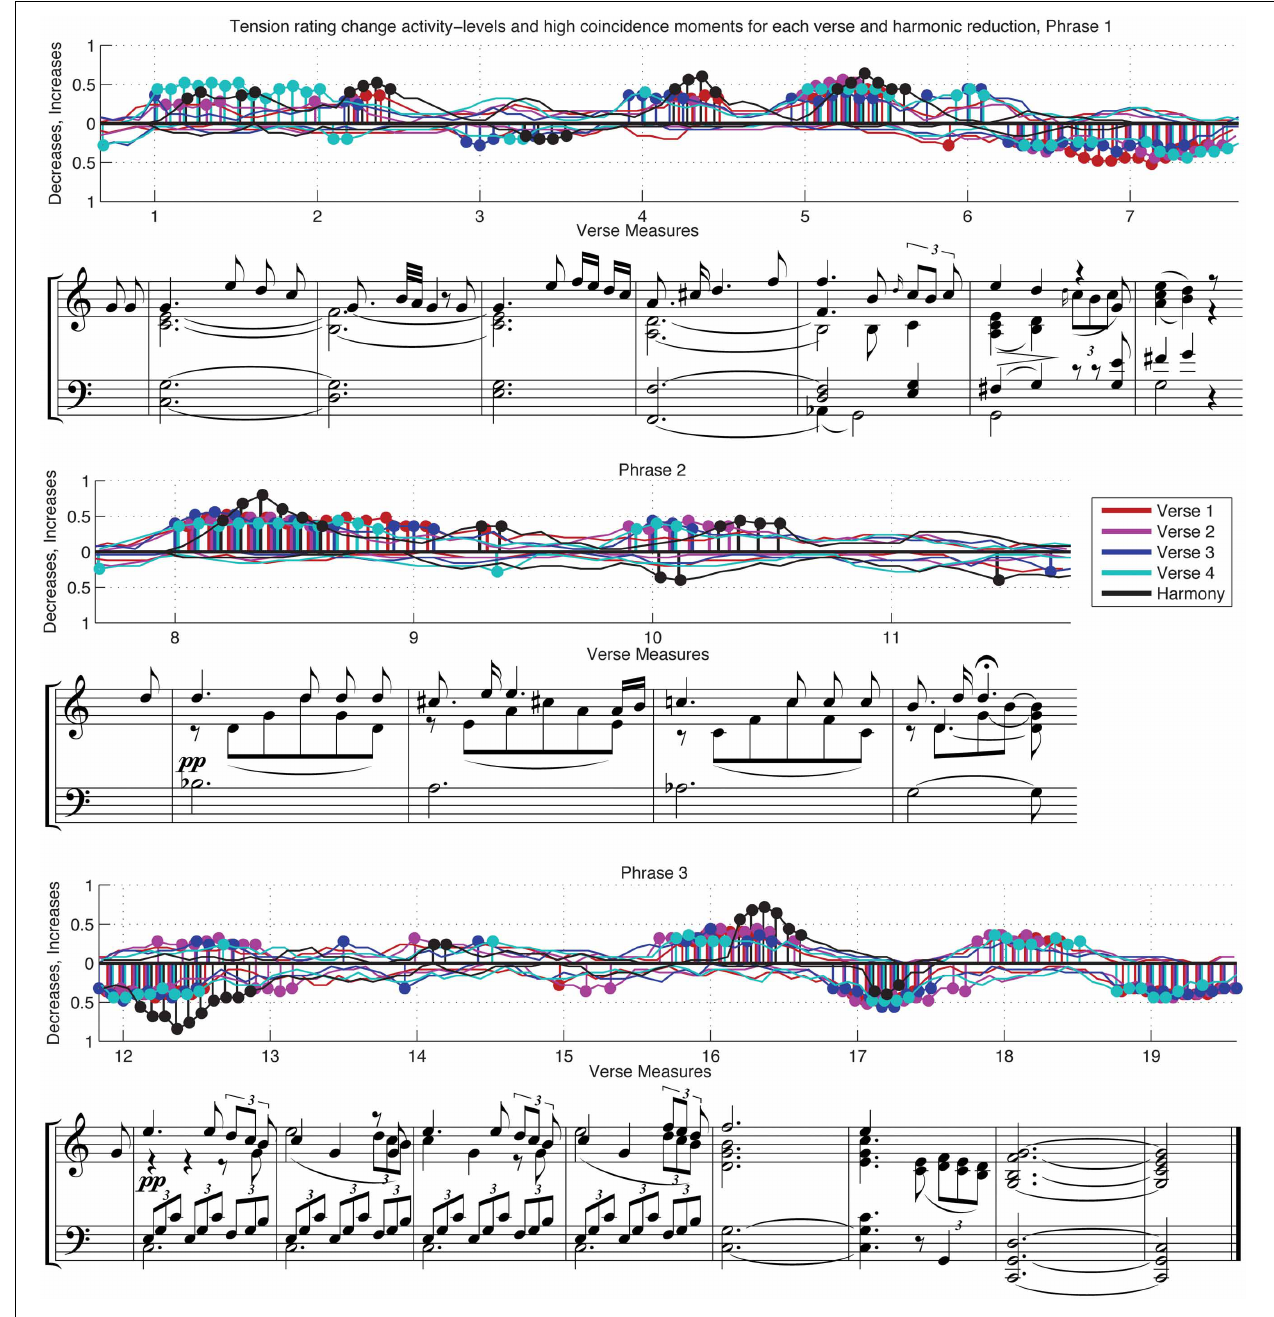
FIGURE 6 | Rating-change activity-level time series of the harmonic reduction and individual verses. Bars and dots mark moments with exceptional activity levels ( p < 0 . 05, as assessed locally). The notated score